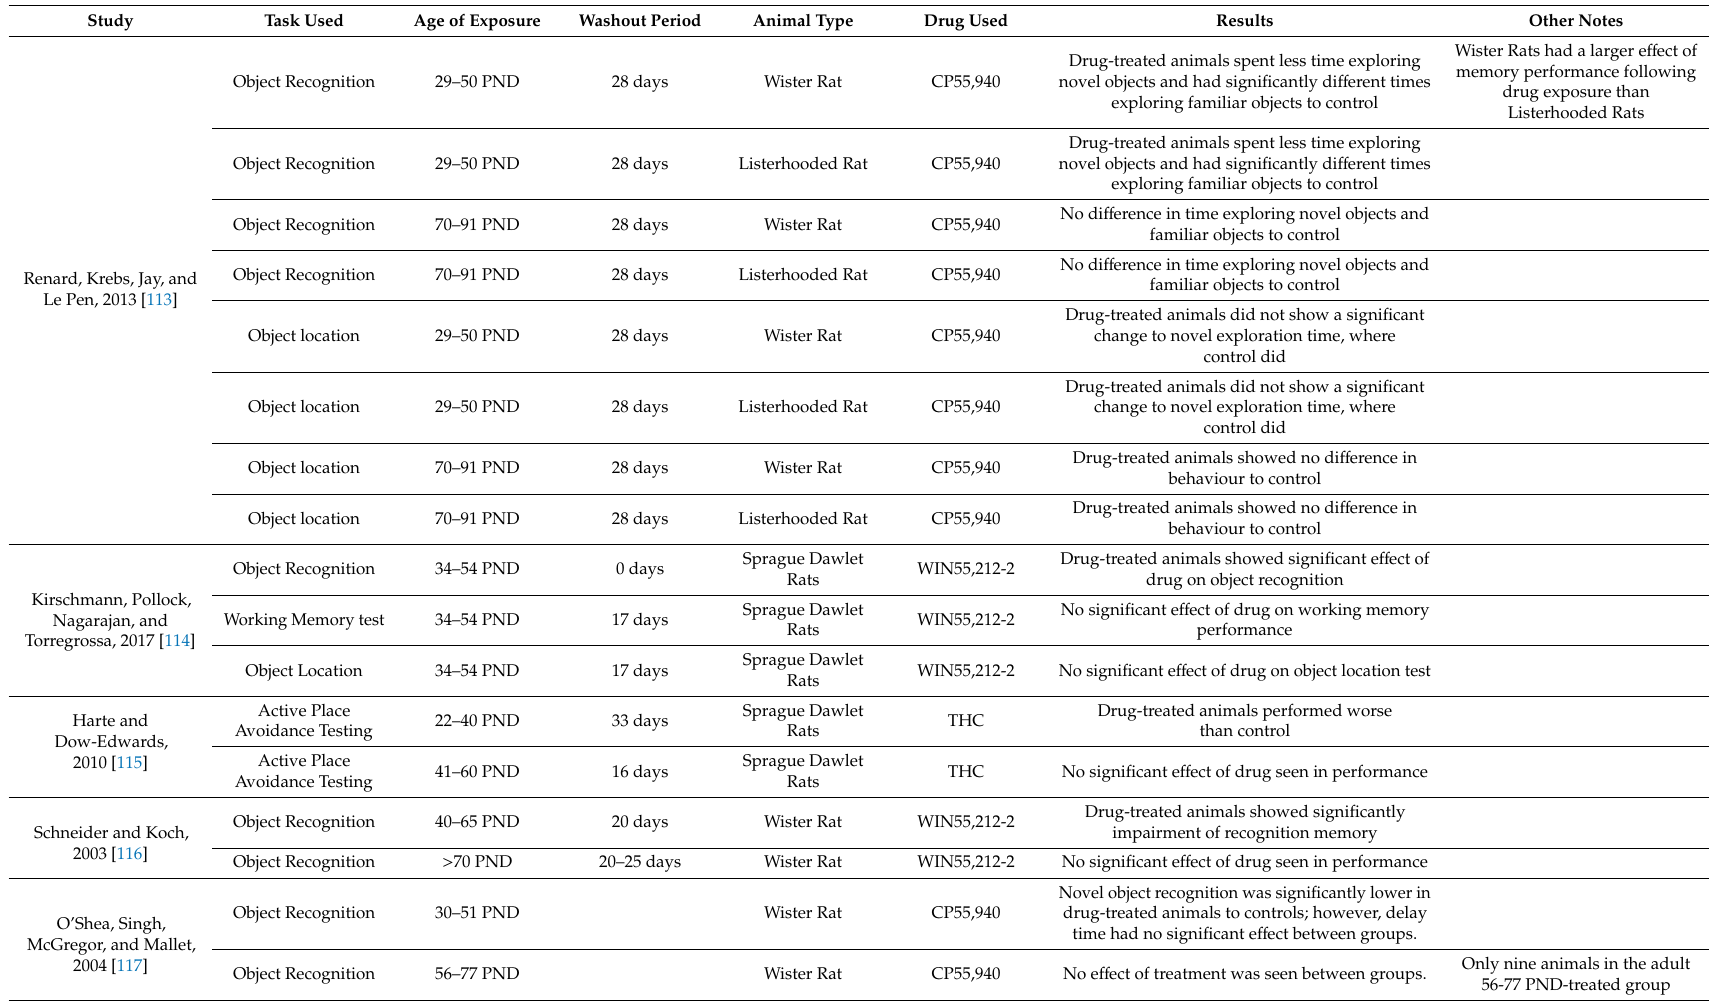
Table 3. Animal studies using memory tasks to investigate exposure to exogenous